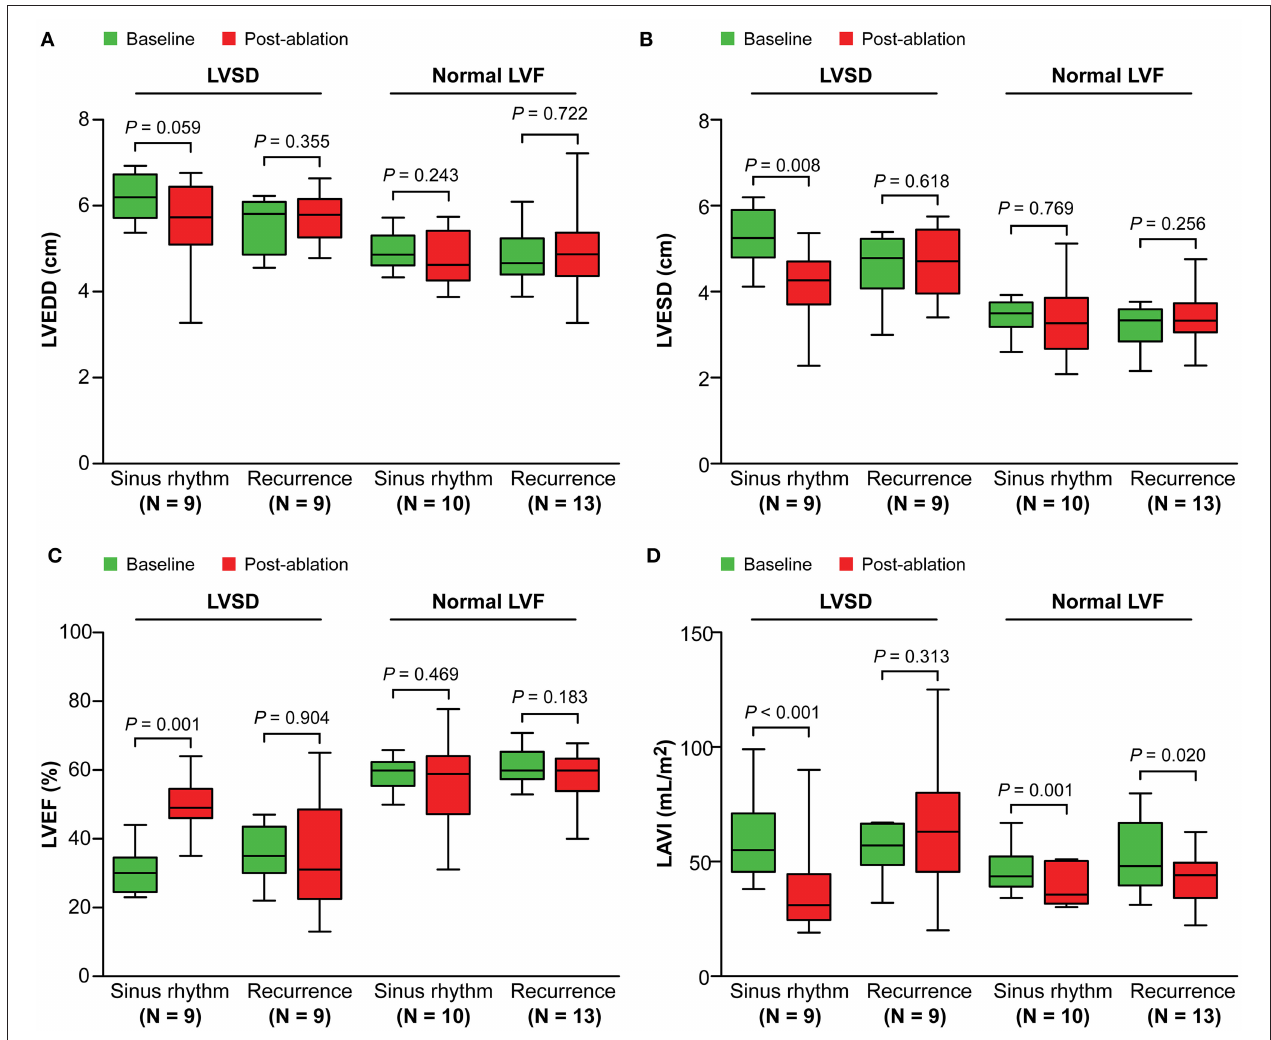
FIGURE 3 | Change in left ventricular dimensions (A,B) , the left ventricular ejection fraction (C) , and the left atrial volume index (D) from baseline to post-ablation. LVSD, left ventricular systolic dysfunction; LVF, left ventricular function; LVEDD, left ventricular end-diastolic dimensions; LVESD, left ventricular end-systolic dimensions; LVEF, left ventricular ejection fraction; LAVI, left atrial volume